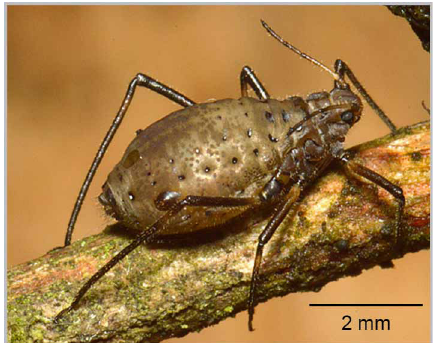
Fig. 69. Cinara (Cinara) kochiana (Börner, 1939). Aptera (from Dransfield & Brightwell 2015, licensed under CC BY 3.0 US, https://creativecommons.org/licenses/by/3.0/us/ legalcode, downloaded 27 Oct.